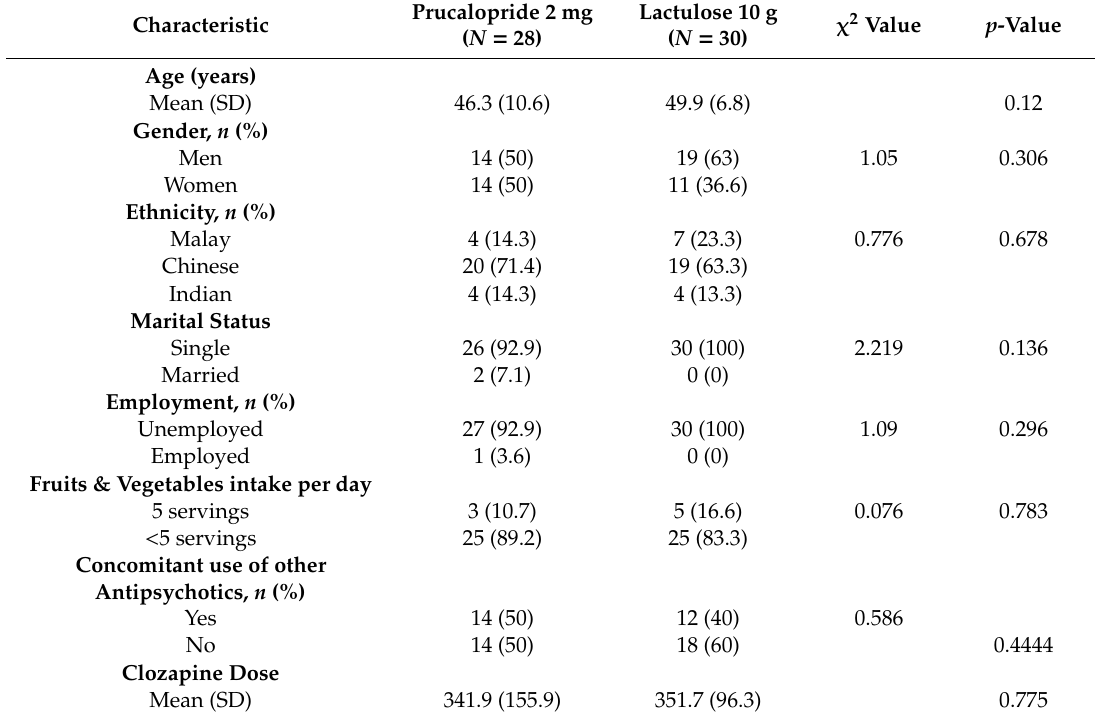
Table 1. Demographics and characteristics of participants with clozapine induced